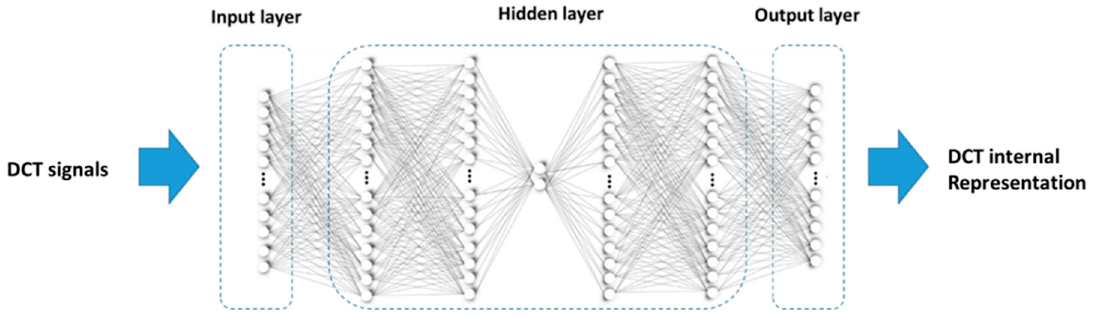
Figure 2. Autoencoder system architecture.